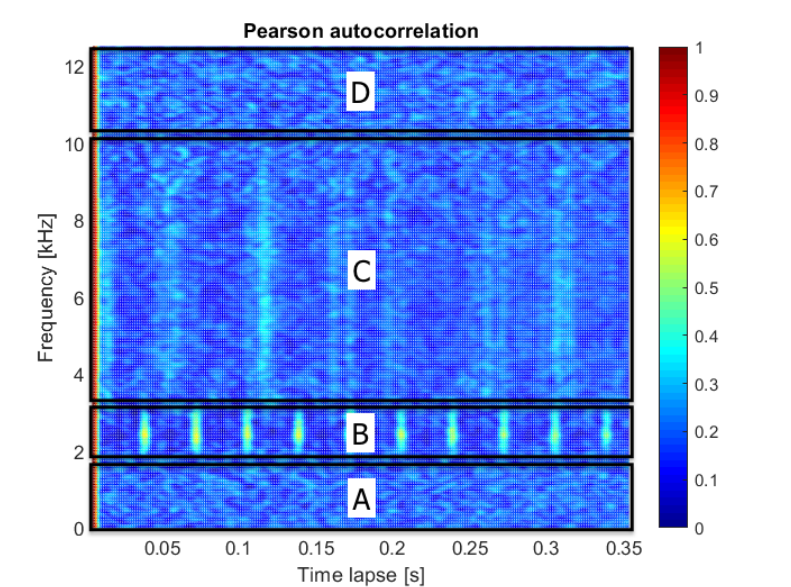
Figure 5. Pearson autocorrelation maps with the highlighted 4 distinguishable parts of the frequency.